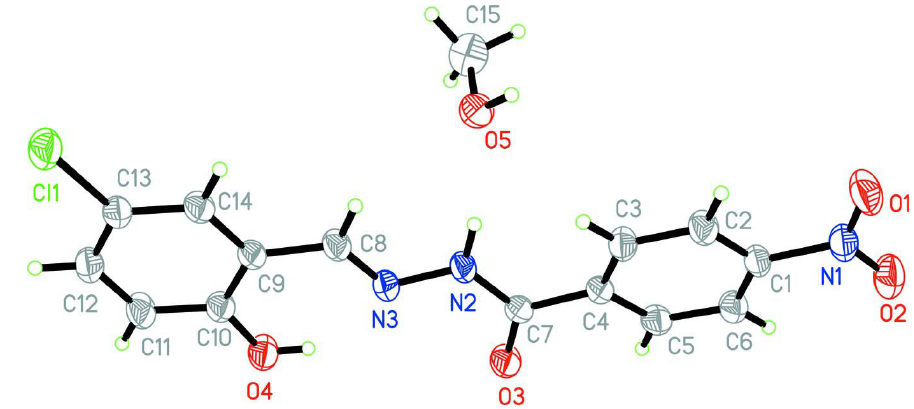
Figure 1 The molecular structure of the title compound with displacement ellipsoids drawn at the 30% probability level.